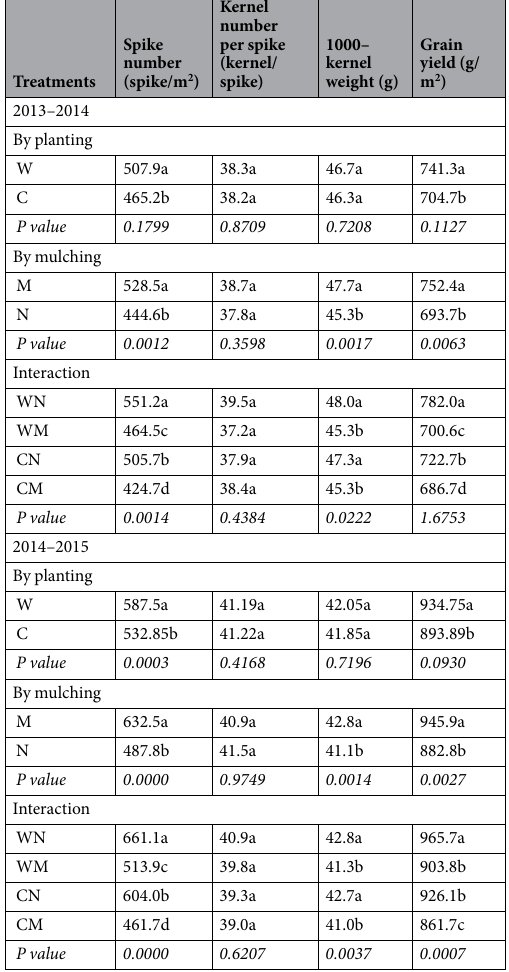
Table 1. Grain yield and yield compositions in 2013–2014 and 2014–2015 winter wheat growing seasons. WN represent wide-precision planting with non-mulching, CN represent conventional-cultivation planting with non-mulching, WM represent wide-precision planting with straw mulching, and CM represent conventional- cultivation planting with straw mulching, respectively. In each growing season, values followed by different letters are significantly (P < 0.05) different among treatments. The in italics are the P value of the significance. When P < 0.05 means “significantly different”, and when P > 0.05 means “not significantly